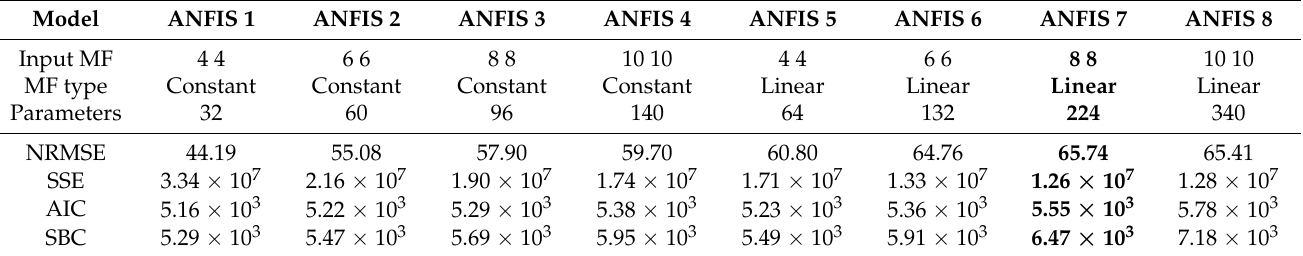
Table 11. Overview of the parameters of the created ANFIS models and performance metrics of the DMSP-20 muscle validation results.